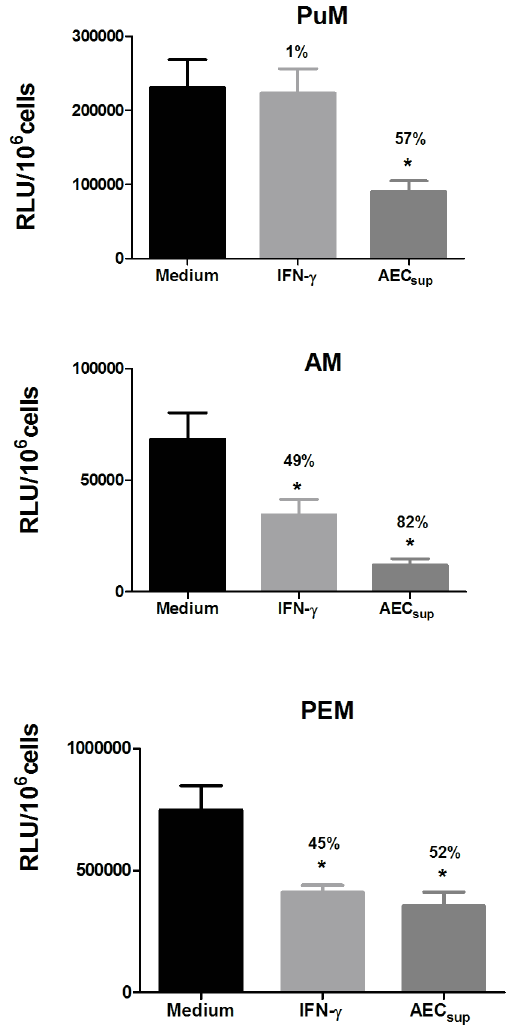
Figure 2. PuM are specifically unresponsive to IFN- c in the control of intracellular bacteria. PuM, AM and PEM were infected with GFP-BCG. After infection, cells were treated with either IFN- c or AEC sup for 48 h or left untreated. Bacterial growth was evaluated by determining RLU. Data are shown as % reduction of phagocytosed bacteria evaluated as RLU. Values are means 6 SD of the mean of 2 independent experiments with 4 replicates each. The differences between groups of PuM, AM and PEM were analyzed using a one- way ANOVA followed by Bonferroni‘s Multiple Comparison Test, * significantly different from medium control, P , 0.05.